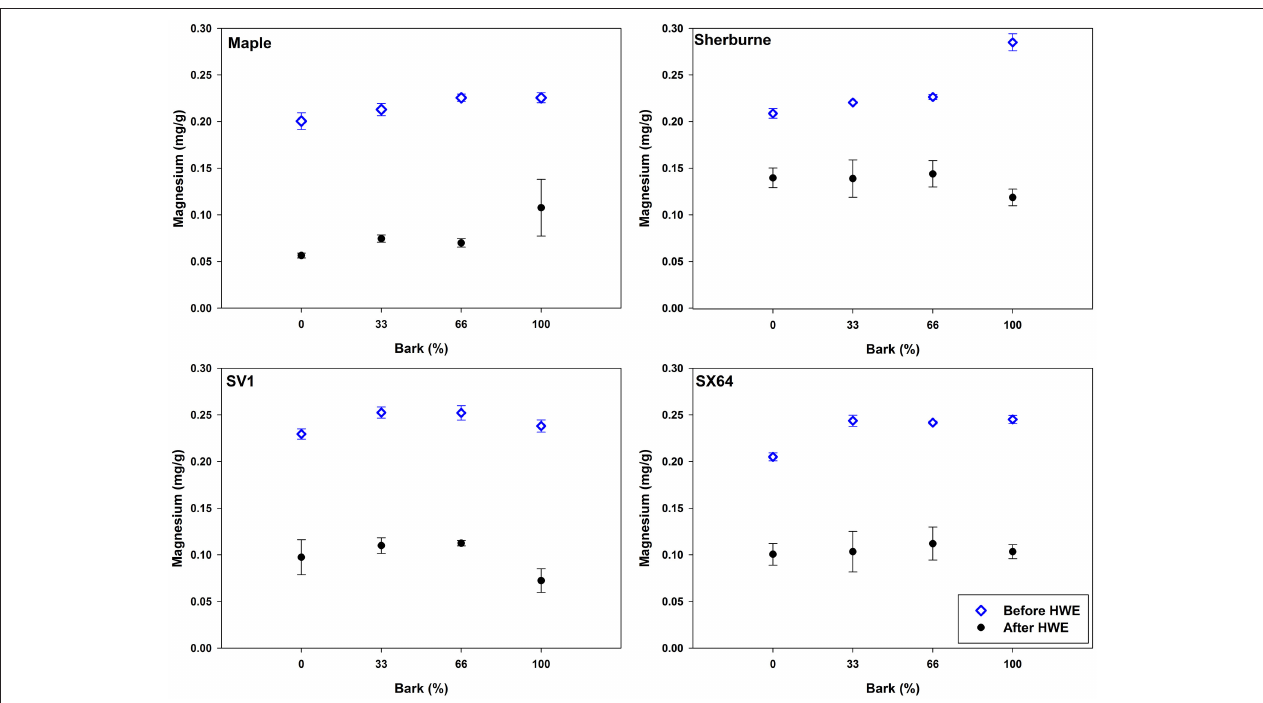
FIGURE 4 | Magnesium content of sugar maple and three willow cultivars with bark levels ranging from 0% to 100% before and after HWE (errors bars represent standard deviations).